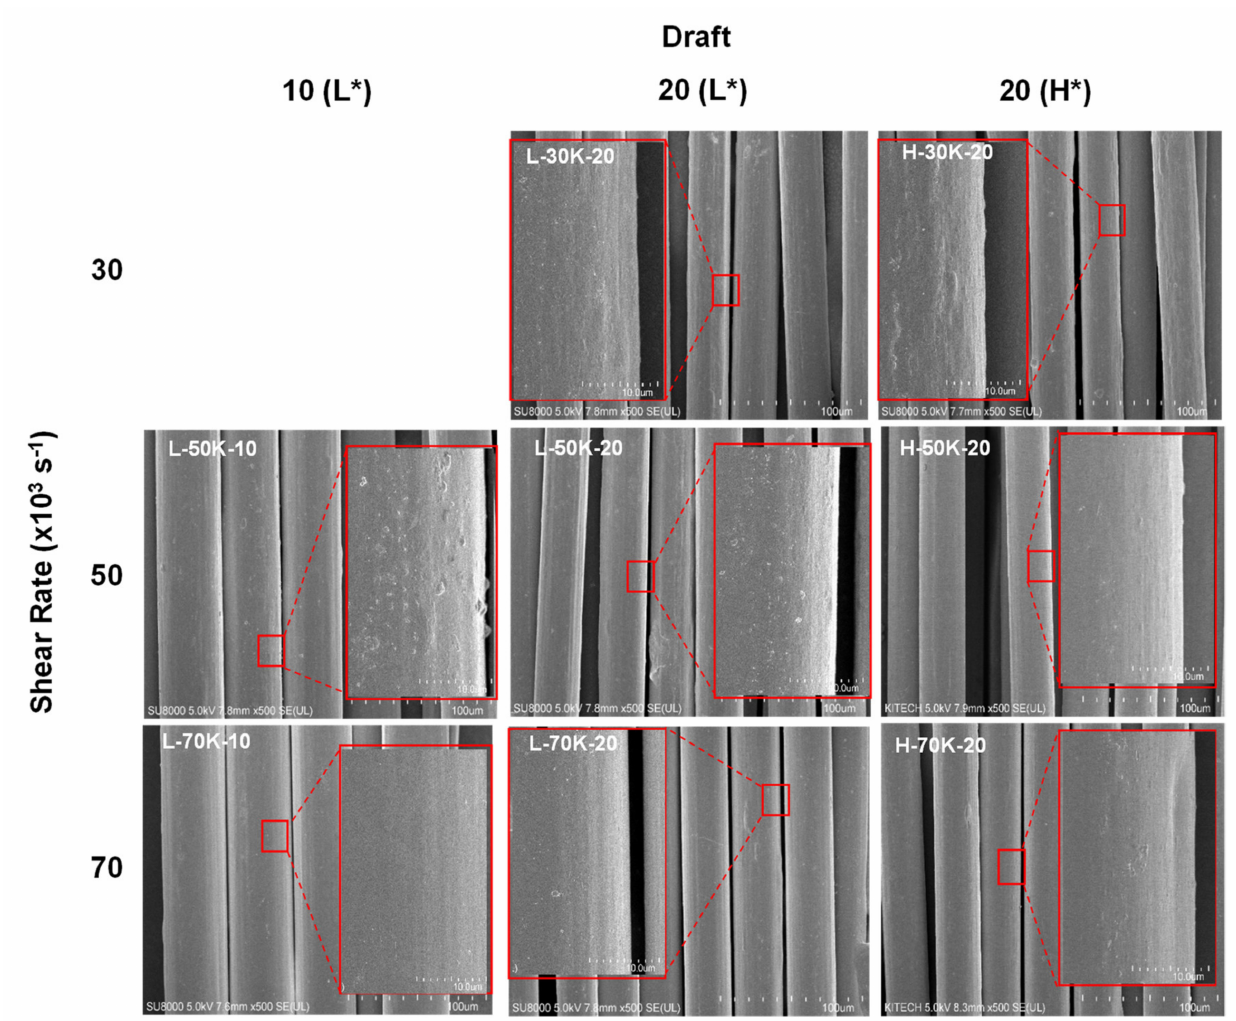
Figure 3. SEM images of the surface of the TLCP as-spun fibers obtained at various spinning conditions. L* and H* indicate the spinning temperatures of 285 and 295 ◦ C, respectively.